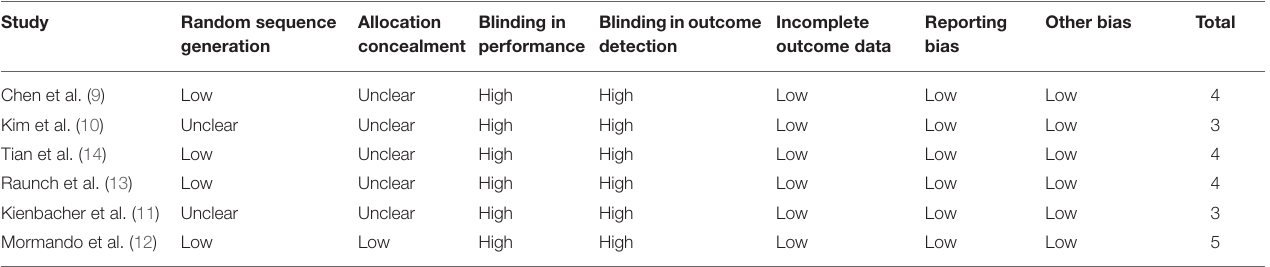
TABLE 2 | Details of quality evaluation for the included RCTs via the Cochrane’s Risk of Bias